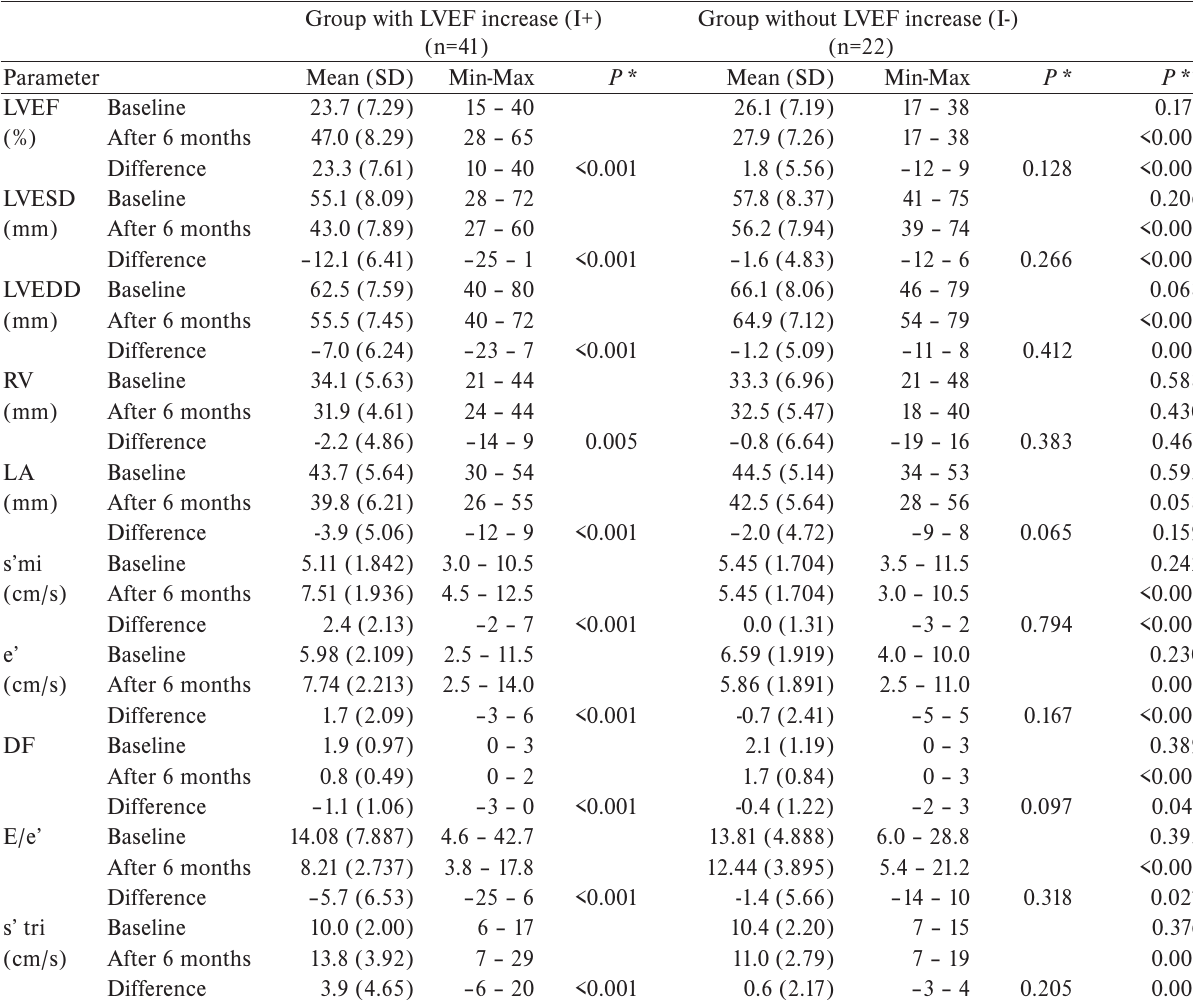
Table 2. Comparison of echocardiographic parameters in the groups with and without LVEF